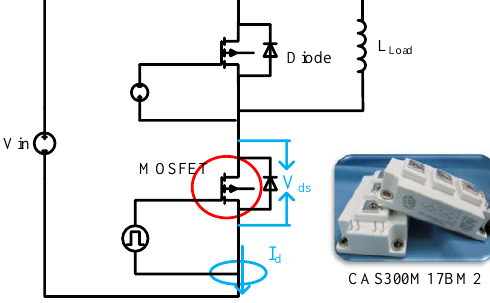
Figure 8. Circuit of Double-Pulse test.